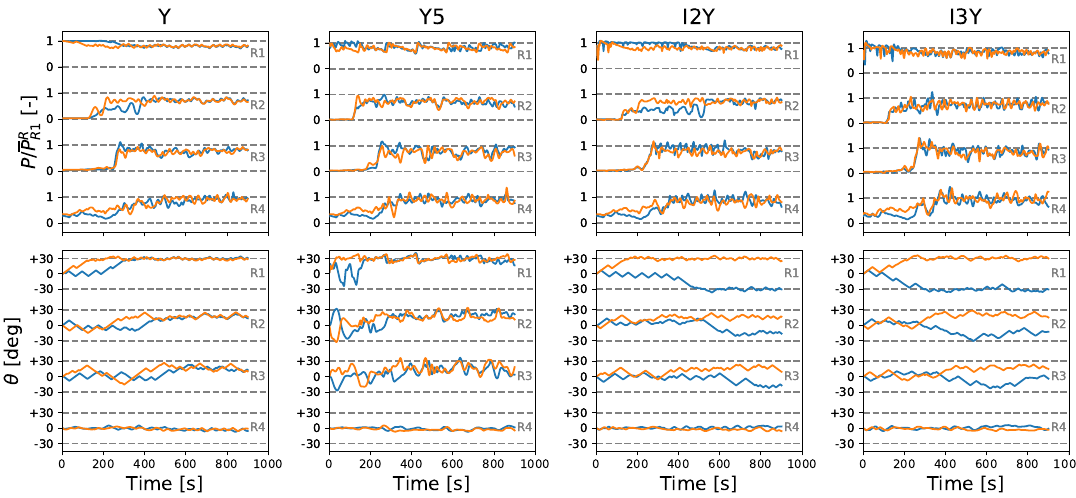
Figure 7. Time evolution of uniform inflow yaw-enabled cases for turbine columns C1 and C4. Top: Turbine power extraction P , normalized by mean first row power in the uncontrolled reference P R R 1 . Bottom: Yaw angle θ . Every line represents a single wind turbine. Line colors indicate different turbine columns defined in Figure 3: The blue lines are for C2 and the orange lines are for